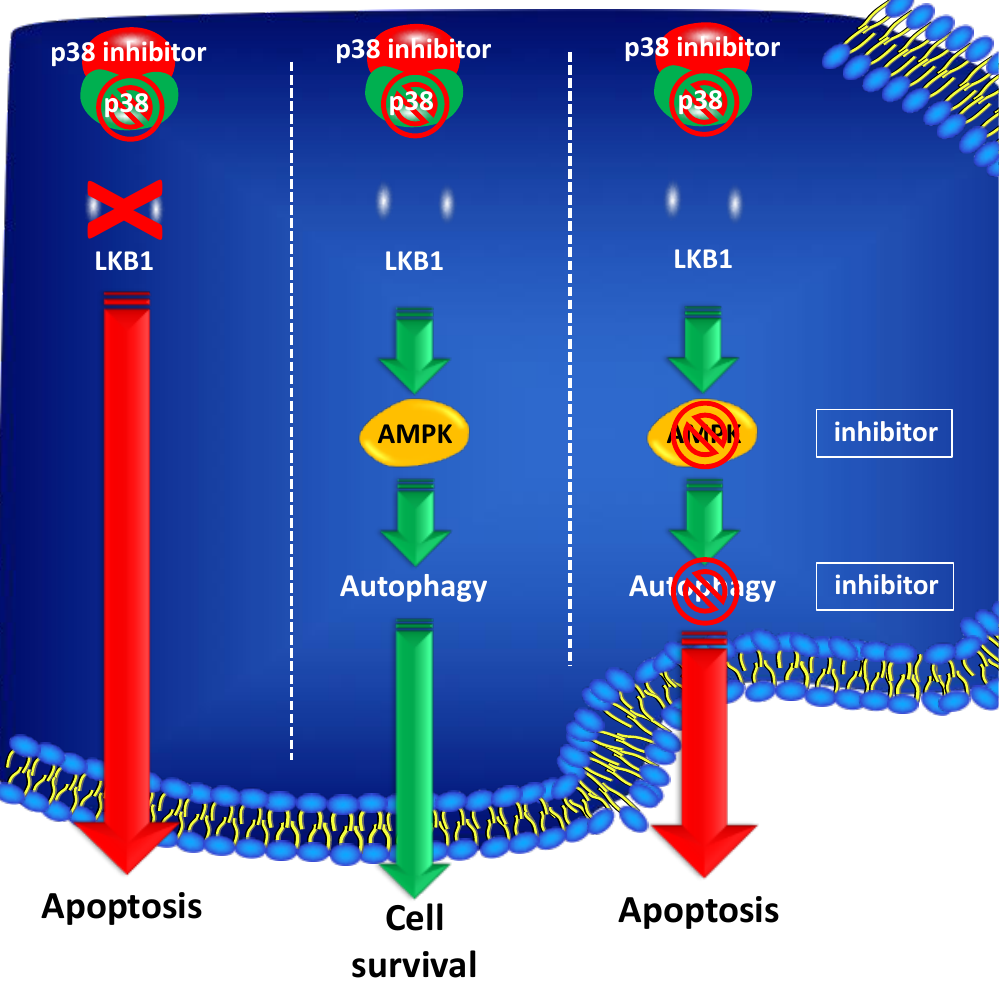
Figure 4. STK11/LKB1 expression is a predictive marker of response to p38MAPK inhibition in PCa. PCa cells with low/absent STK11/LKB1 expression undergo cell death after treatment with p38MAPK inhibitors. PCa cells expressing high levels of STK11/LKB1, show resistance to p38MAPK blockade, by activating autophagy. Conversely, inhibition of autophagy or of AMPK, triggers apoptosis in STK11/LKB1 expressing cells treated with p38MAPK inhibitors.